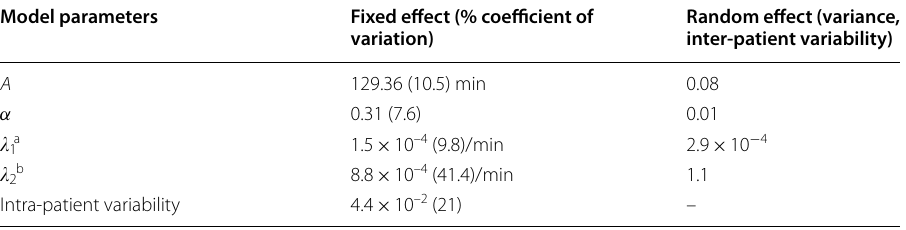
Table 2 Parameters estimated from ATP fitting using the best model obtained from the best function derived using MS–NLME method, i.e. f 4 d